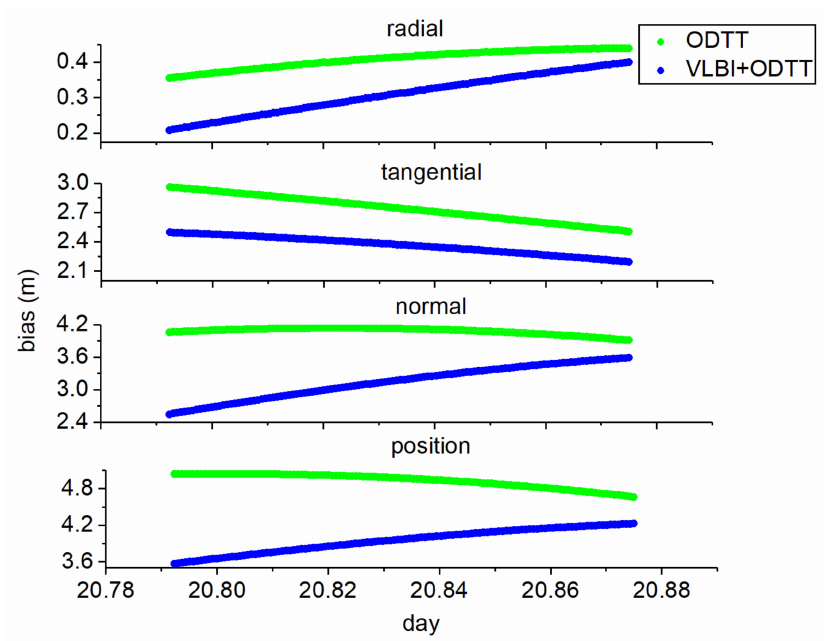
Figure 9. The bias during the period of 20 August 19:00–20 August